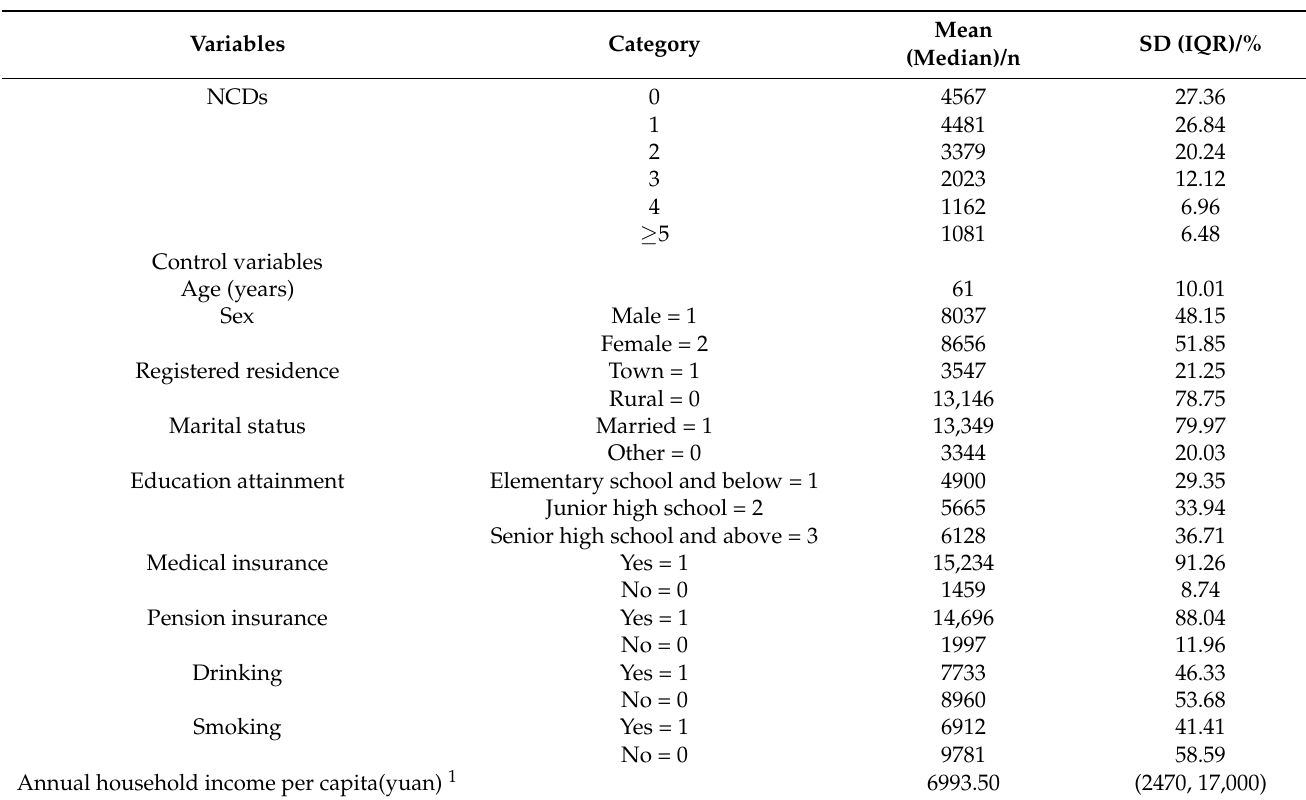
Table 3. Variable descriptions ( n = 16,693).